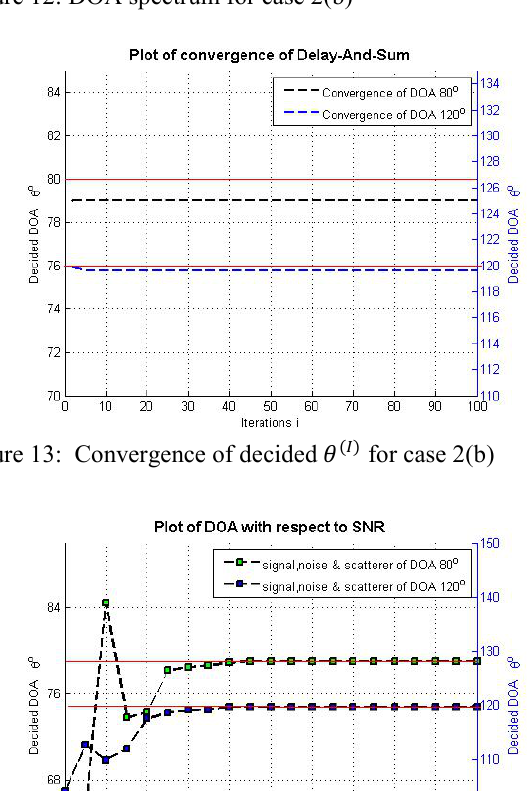
Figure 12: DOA spectrum for case 2(b)